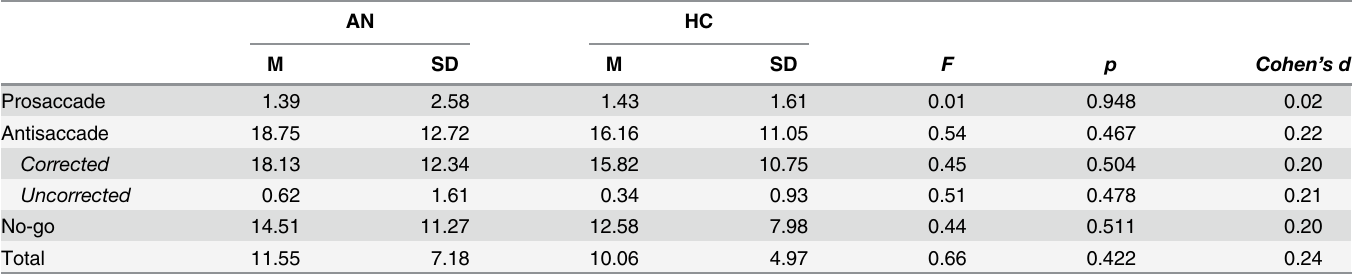
Table 4. Prosaccade/antisaccade/no-go saccade task error rates. AN HC M